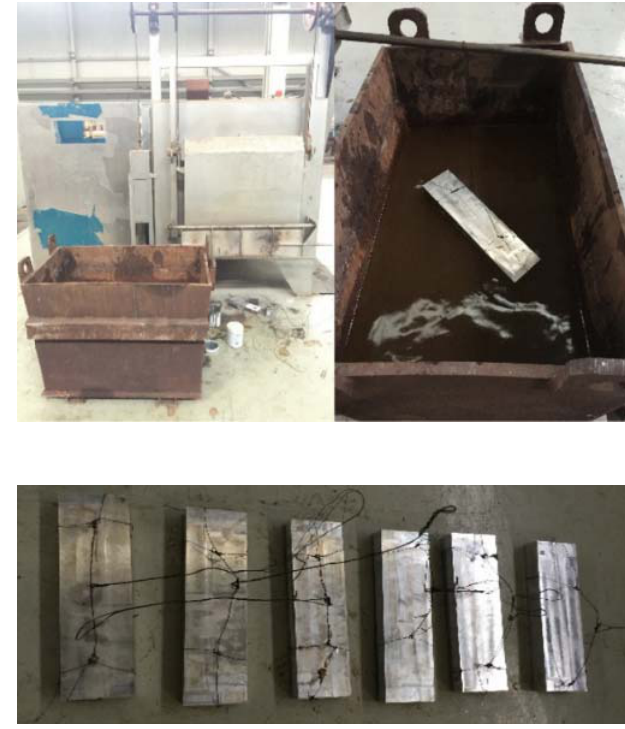
Figure 1. Quenching experiment.